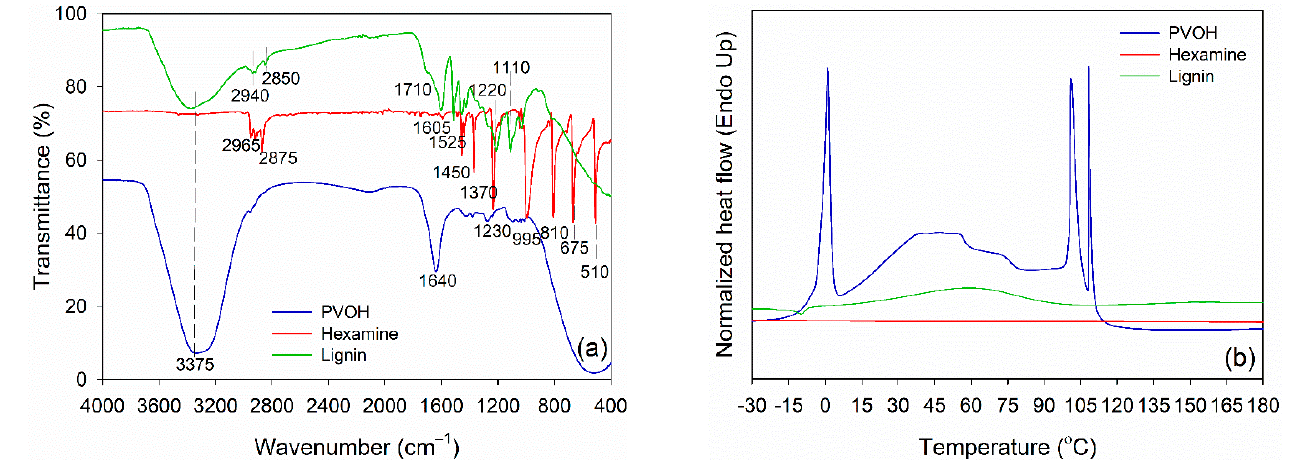
Figure 2. Characteristics of PVOH, hexamine, and lignin. ( a ) FTIR spectra, ( b ) DSC thermograms.